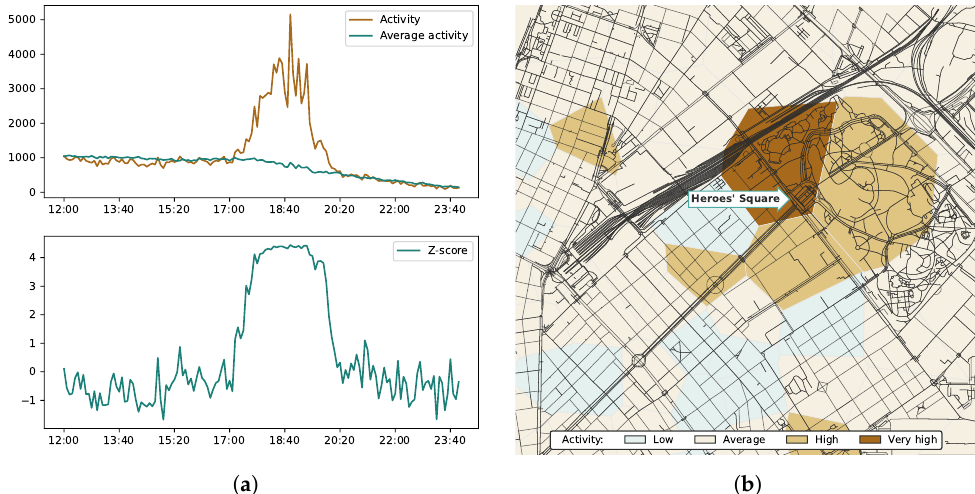
Figure 18. Mobile phone network activity at Heroes’ Square and the surrounding neighborhood during the welcoming event for the Hungarian national football team. The activity and the Z-score of the site at Heroes’ square ( a ), and the spatial view at 18:35 ( b